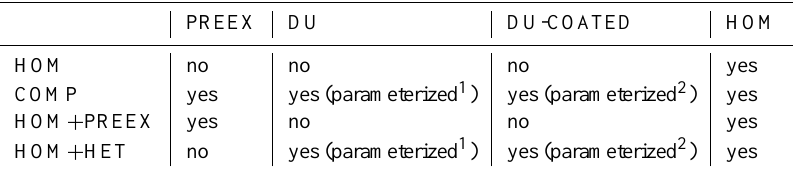
Fig. 2. Annual zonal means of ICNC (first column), the particle size before the larger particles are transferred to snow R i (second column), Fig. 2. the number concentration of heterogeneous IN (in the case of DU, and DU-COATED) and of solution droplets (in the case of HOM) N a (third column), the percentage frequency of N i /N a = 1 (fourth column) and the fraction of heterogeneously formed ICNC divided by all to snow R i (second column), the number concentration of heterogeneous IN (in case of DU and DU - ) newly nucleated ICNC (fifth column) for the different ice modes – PREEX, DU, DU-COATED and HOM – inside the cloudy part of the grid box. Note that N a is given in L − 1 in the case of heterogeneous nucleation and incm − 3 in the case of homogeneous freezing. The black line and of solution droplets (in case of HOM ) N a (third column), the percentage frequency of N i /N a = 1 shows the annual mean tropopause and the red line illustrates the mean position of the − 35 ◦ C isotherm. Table 2. Overview over simulations. We show which of the four ice modes – PREEX, DU, DU-COATED and HOM – are active in each PREEX , DU , DU - COATED , HOM inside the cloudy part of the grid box. Note that simulations, as well as the details of heterogeneous ice nucleation. The notations “parameterized 1 ” and ‘parameterized 2 ” mean that f a,DU − 3 and S cr , DU are parameterized according to Eq. (4); and f a,DU-COATED = 0 . 05 and S cr , DU − COATED = 1 . 3, respectively. − 35 ◦ PREEX